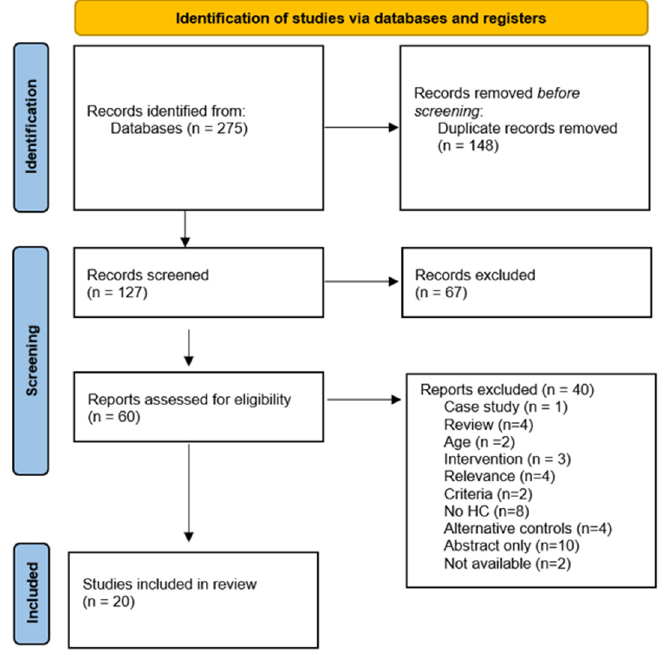
Figure 1. PRISMA 2020 flow diagram of literature search for included studies in this review of sleep and ME/CFS.